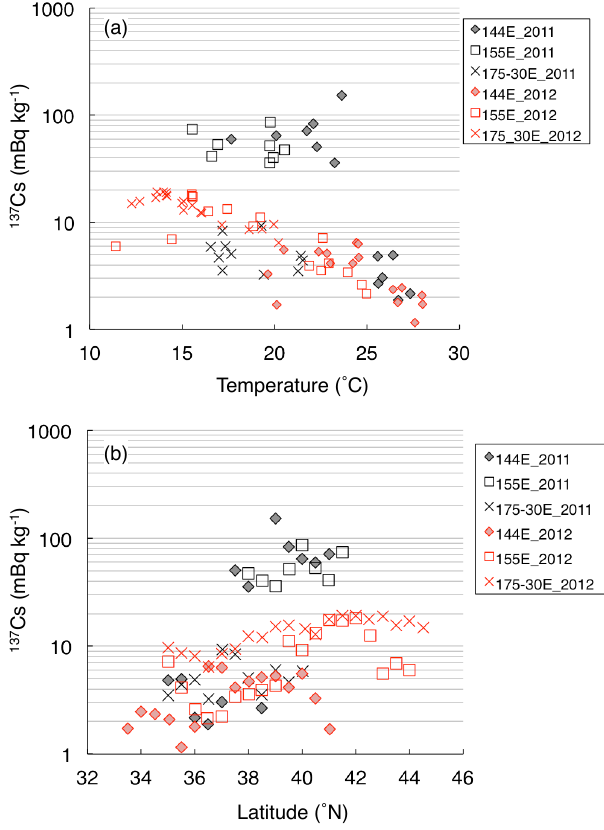
Fig. 5. (a) Relationship between concentrations of 137 Cs and sea- water temperature at 5m depth during July 2011 and July 2012. (b) Relationship between concentrations of 137 Cs and